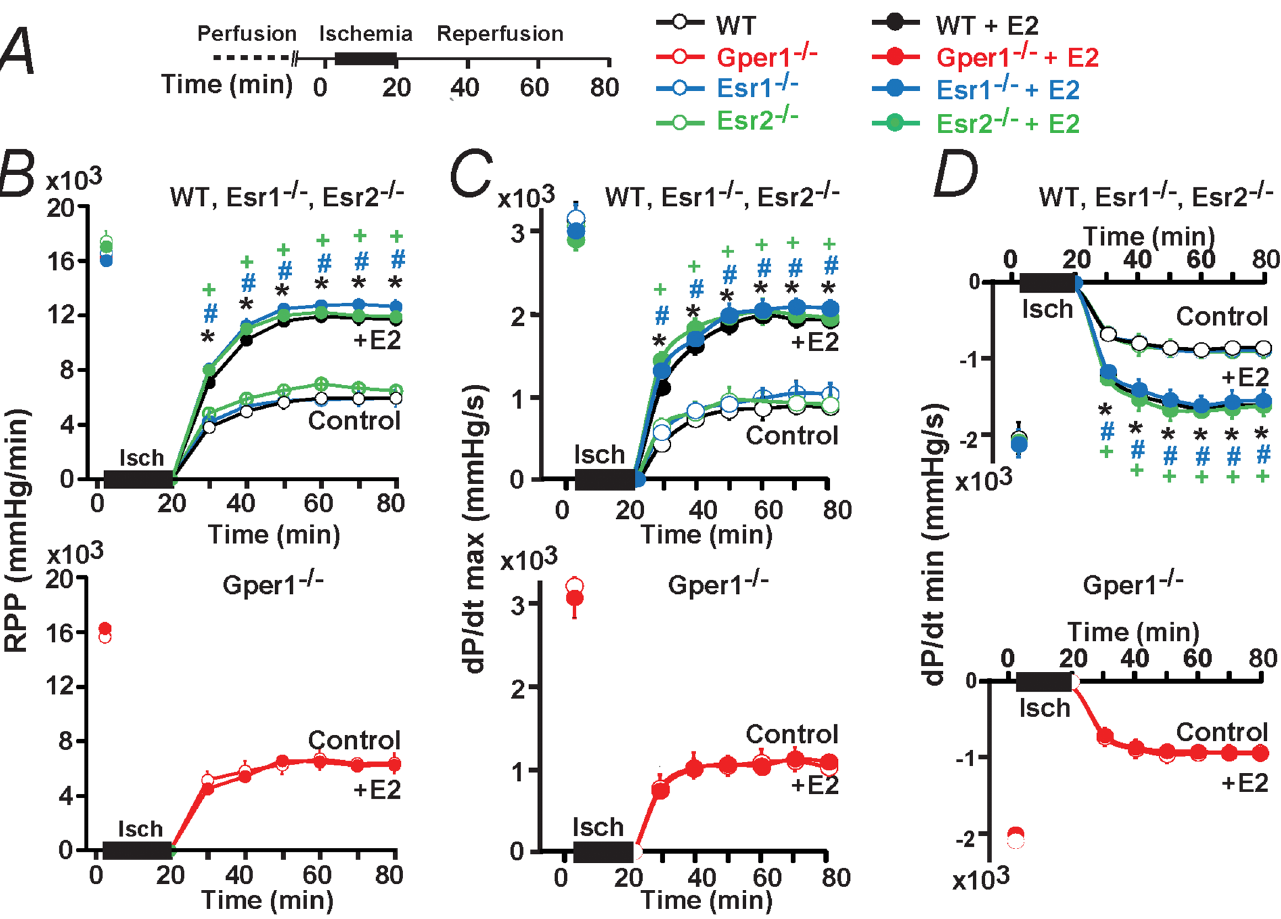
Fig 3. Time course of cardiac function after I/R in control and after E2 treatment in WT, Esr1 -/- , Esr2 -/- and Gper1 -/- . A. Ischemia/reperfusion (I/R) protocol used to perfuse mouse hearts isolated from WT, Esr1 -/- , Esr2 -/- and Gper1 -/- male animals. B-D. Time course of Rate Pressure Product (RPP) ( B ), Maximum Velocity of Contraction (dP/dt max) ( C ) and Minimum Velocity of Relaxation (dP/dt min) ( D ). During the reperfusion period, E2 produced an improvement of all of the functional recovery parameters compared to control in WT, Esr1 -/- , and Esr2 -/- ( B-D , top); however, E2 had no effect when using Gper1 -/- hearts (B-D, bottom). Data points were obtained by averaging 2 min values before ischemia and every 10 min of reperfusion. Values are mean ± SEM; * P < 0.05 E2-treated versus control in WT; + P < 0.05 E2-treated versus control in Esr2 -/- , # P < 0.05 E2-treated versus control in Esr1 -/- . n = 6 – 8 hearts/